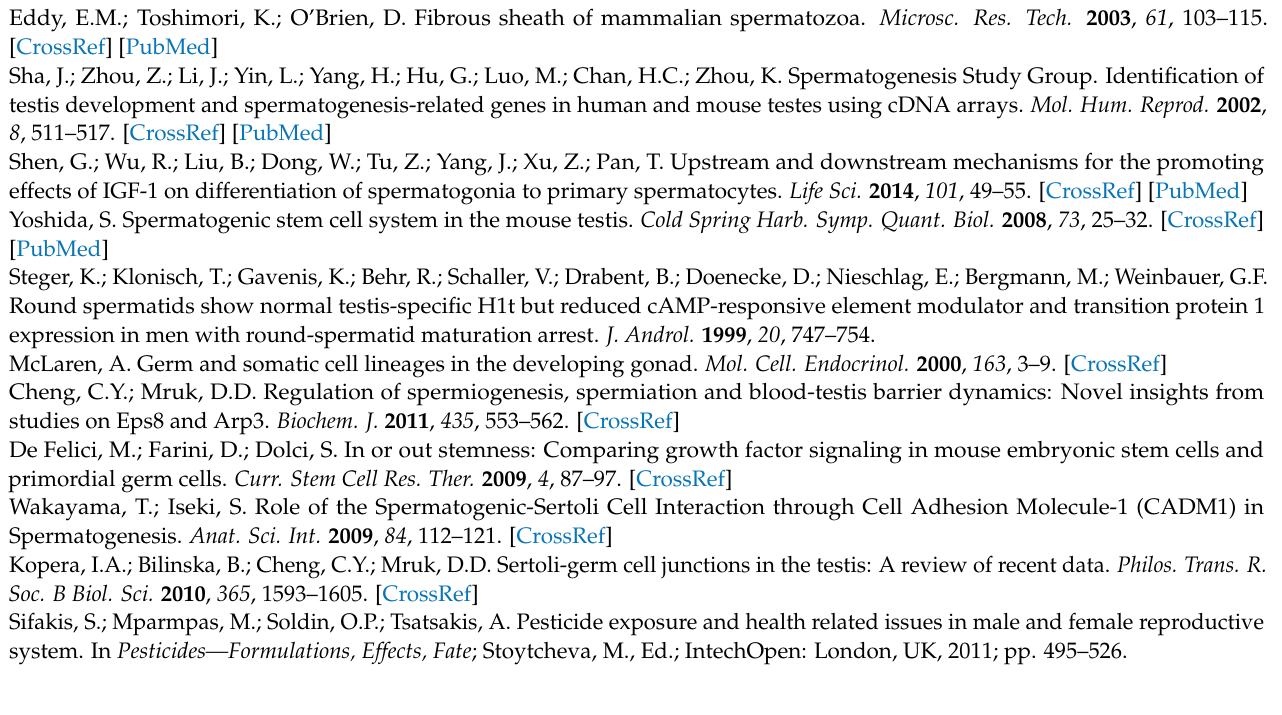
tissues of perfused male rats, Figure S2: Peptide competition control against APEH in rat epididymis, Figure S3: Inhibition of APEH activity in reproductive tissues and isolated